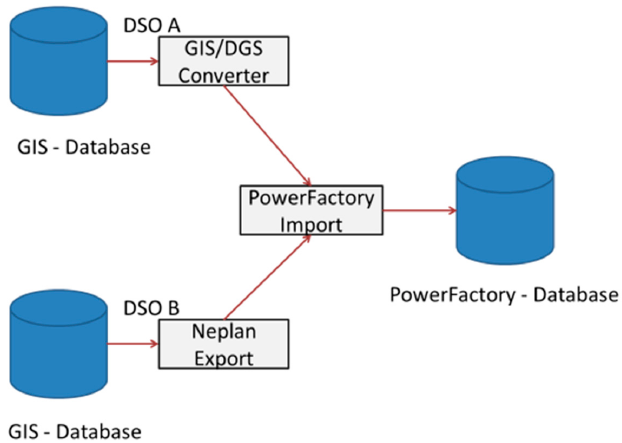
Figure 1. Automated network data import.